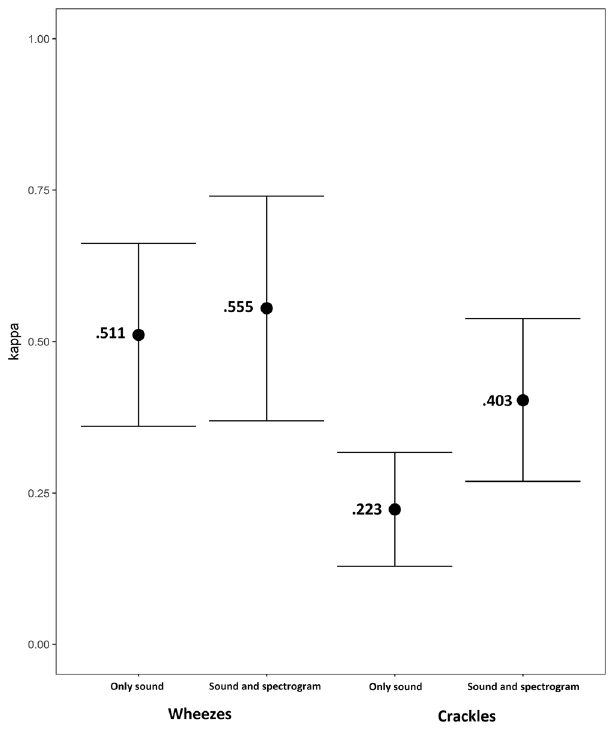
Figure 3. Fleiss kappa for the group of 23 participants when classifying wheezes and crackles with only sound and sound plus spectrogram.